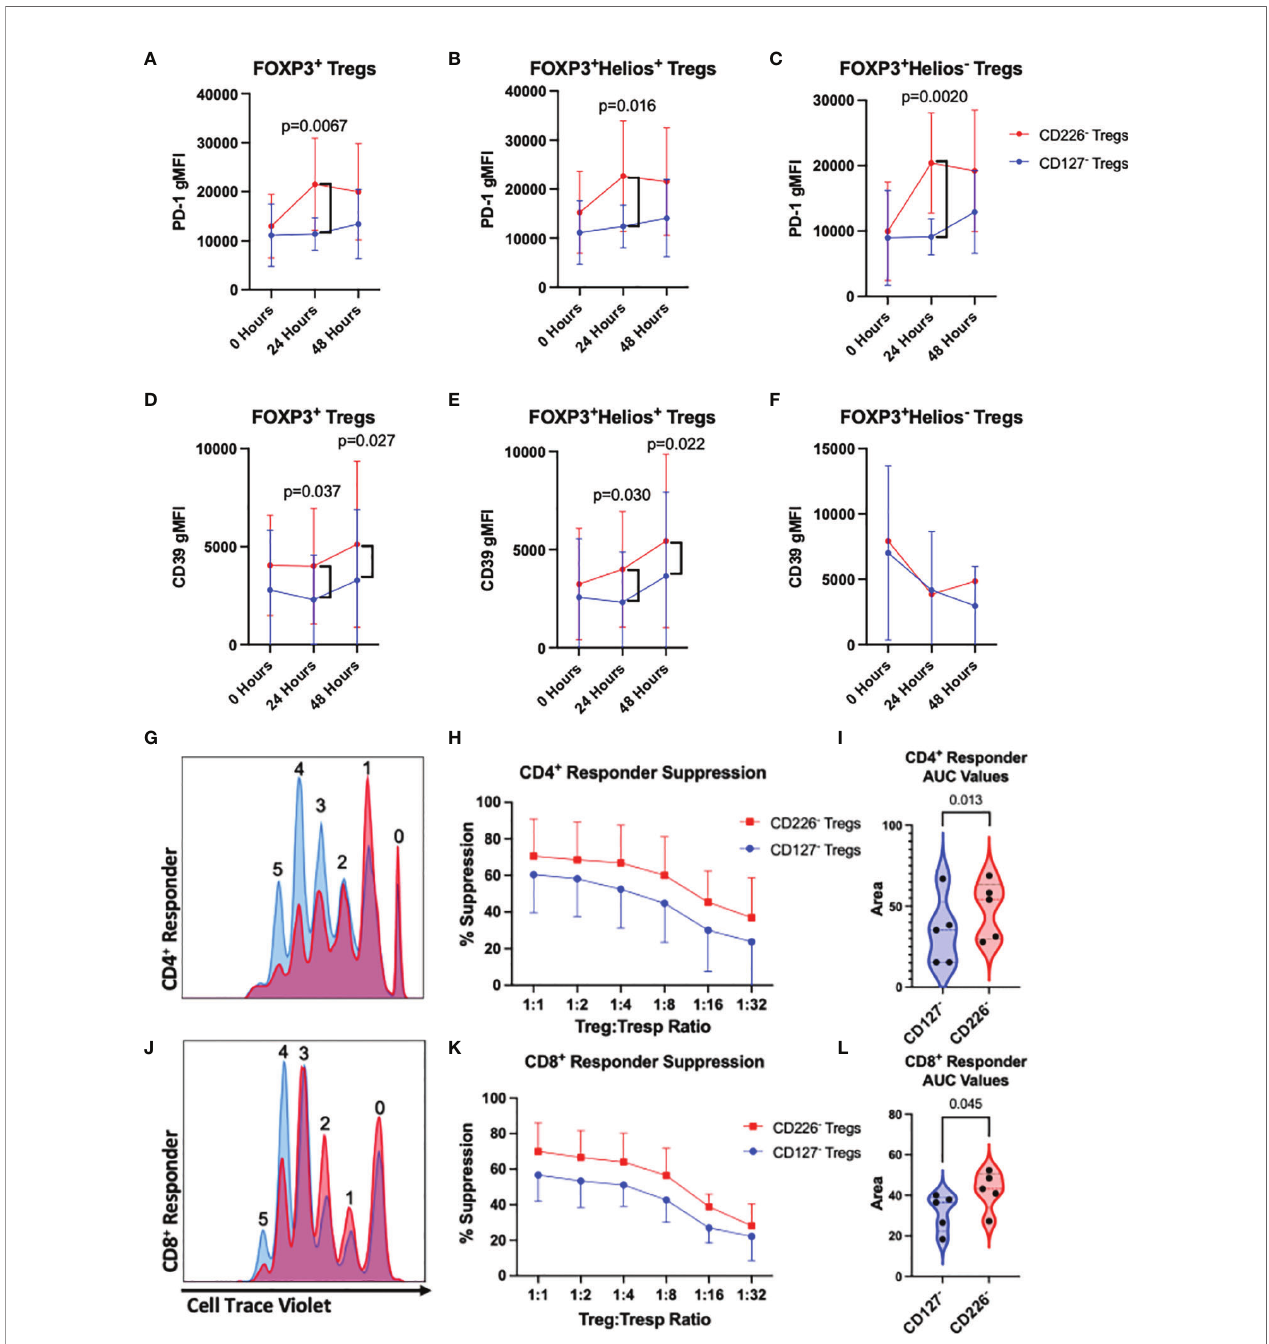
FIGURE 6 | CD226 - Tregs demonstrate an increased suppressive phenotype and ex vivo suppressive capabilities as compared to CD127 lo/- Tregs. (A – C) PD-1 and (D – F) CD39 expression was assessed by fl ow cytometry on total FOXP3 + Tregs (A, D) , FOXP3 + Helios + Tregs (B, E) , and FOXP3 + Helios - Tregs (C, F) from 14-day ex vivo expanded CD127 lo/- sorted Tregs versus CD226 - Tregs following co-culture with autologous PBMCs in the presence of soluble a -CD3 and a -CD28 for 0, 24, or 48 hours. n = 5 biological replicates. Signi fi cant P-values reported on the fi gure for two-way ANOVA with Bonferroni ’ s multiple comparison between Treg isolation conditions of matched subjects. CD127 lo/- sorted Treg (blue) and CD226 - sorted Treg cultures (red) were by expanded for 14-days ex vivo , then labeled with Cell Proliferation Dye eFluor670 and co- cultured in decreasing two-fold dilutions with CellTrace Violet-labeled autologous responder PBMCs in the presence of soluble a -CD3 and a -CD28 antibodies for four days before fl ow cytometric assessment of (G – I) CD4 + and (J – L) CD8 + T cell proliferation. (G, J) Representative dye dilution plots demonstrating suppression of responders. Percent suppression of (H) CD4 + and (K) CD8 + responders was quanti fi ed by the division index method, and comparisons between FACS conditions were made using (I, L) area under the curve (AUC) values for each percent suppression curve (40, 41). Data re fl ects n = 5 biological with n = 3 technical replicates. Signi fi cant P-values are reported on the fi gure for paired T-tests comparing Treg isolation conditions from matched